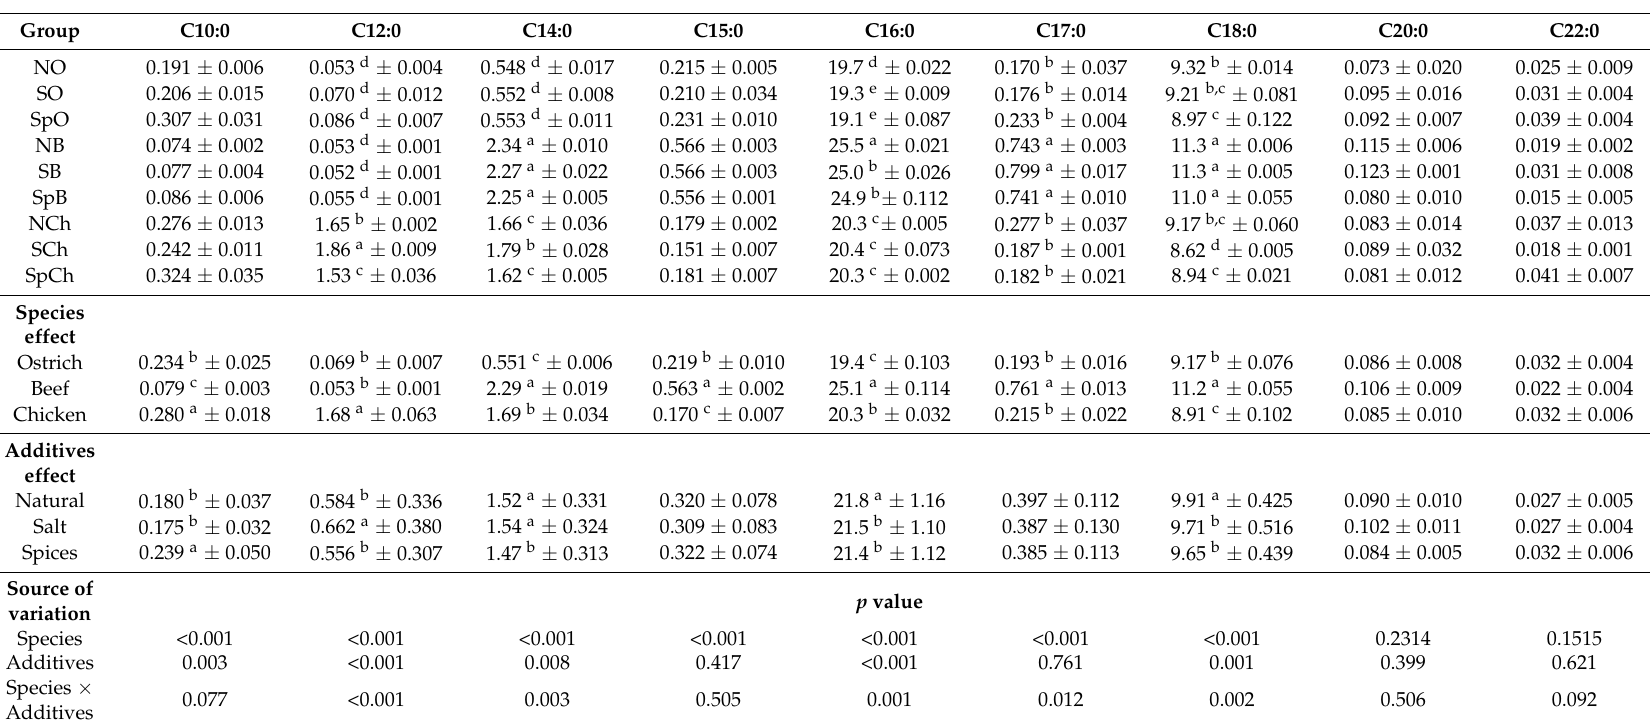
Table 2. Saturated fatty acid composition in dried meat (%) (mean ±